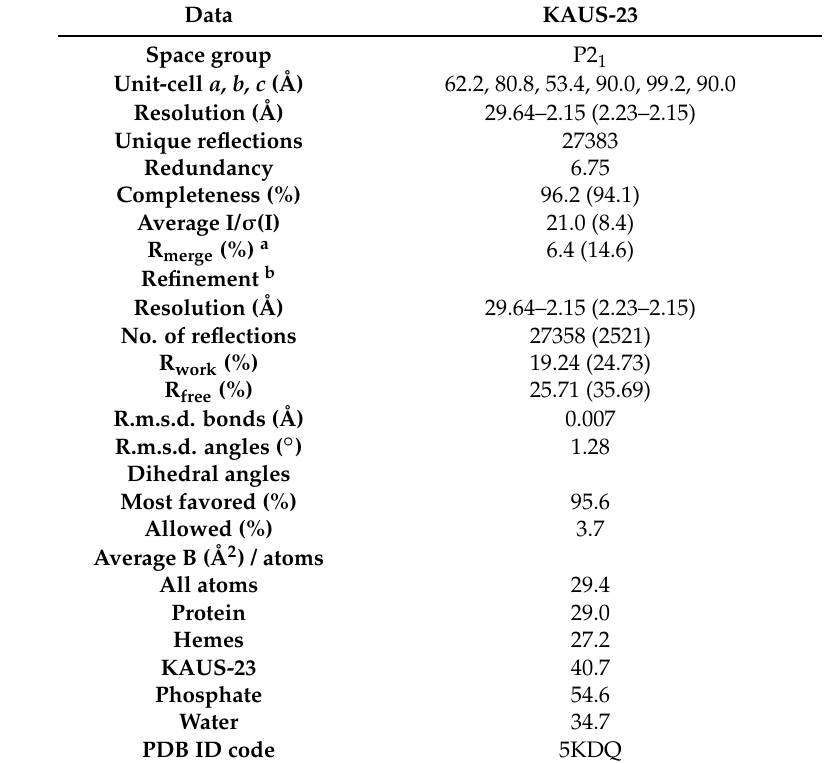
Table 3. Data collection and refinement statistics of deoxygenated Hb in complex with KAUS-23. Numbers in parentheses are for the highest resolution